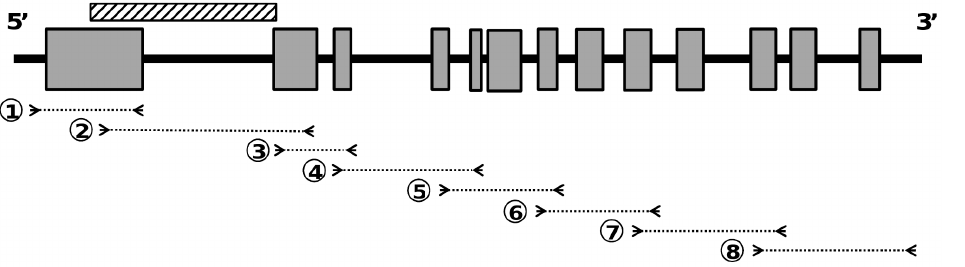
Figure 1. Position of primers used for CRTISO amplification. Boxes and lines represent exons and introns, respectively, of the CRTISO sequence. Arrows indicate partial sequences amplified with primers. The hatched box above the CRTISO sequence corresponds to the partial sequence analysed by [25].